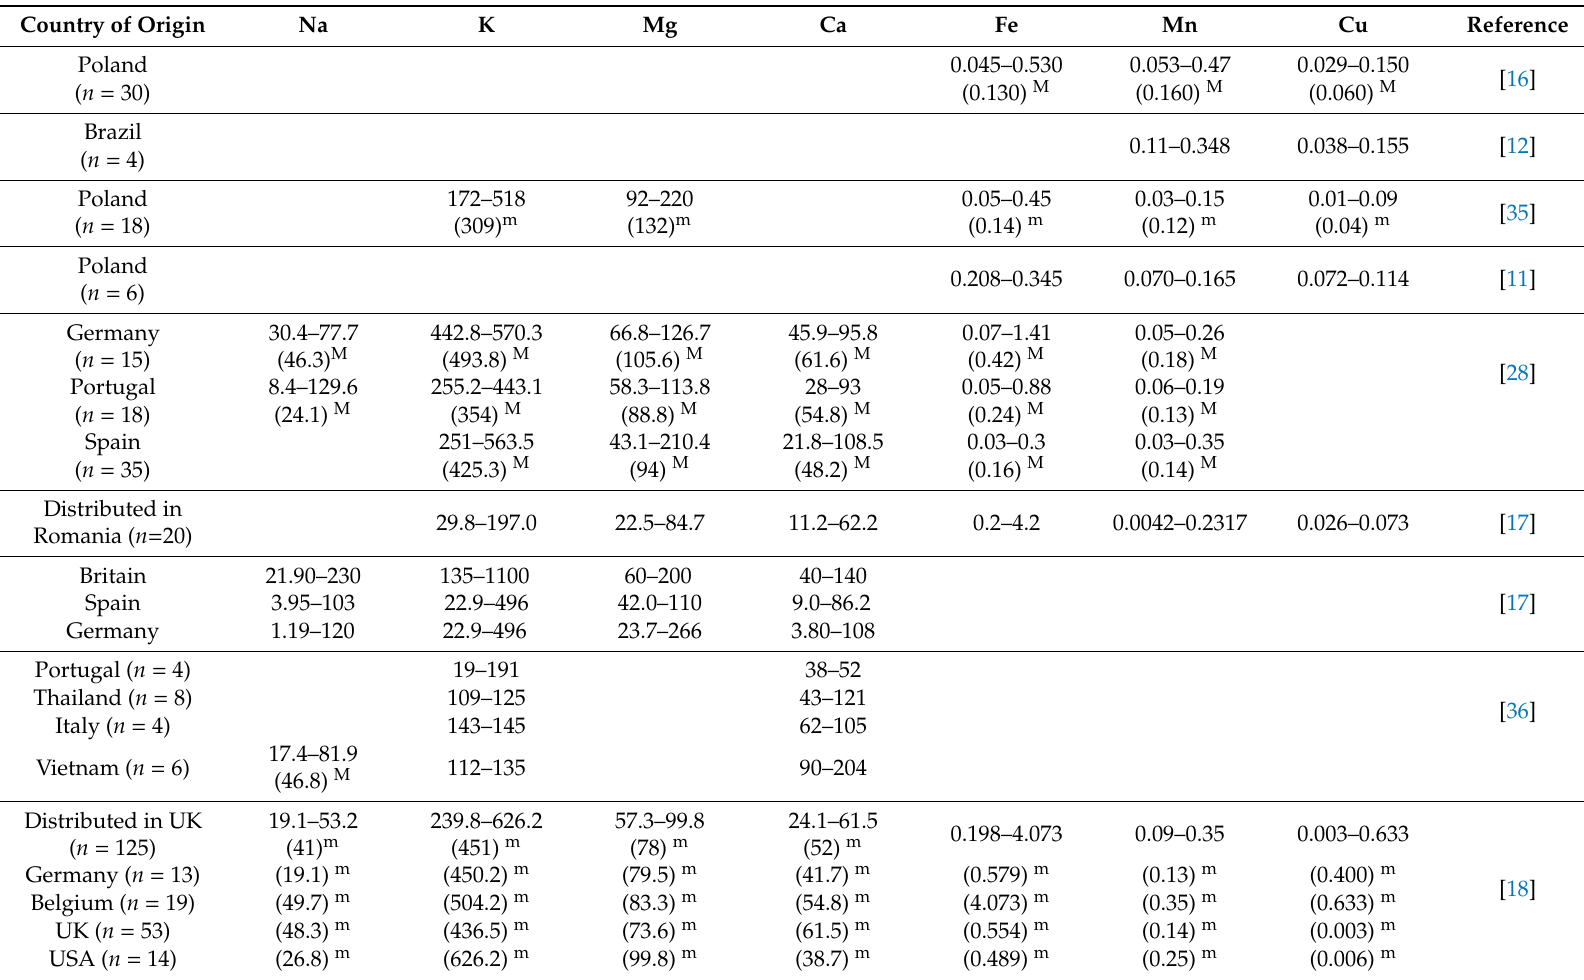
Table 3. Concentration of elements (mg / L) in beers manufactured in di ff erent countries; ranges, mean (m), and median values (M) in brackets. Country of